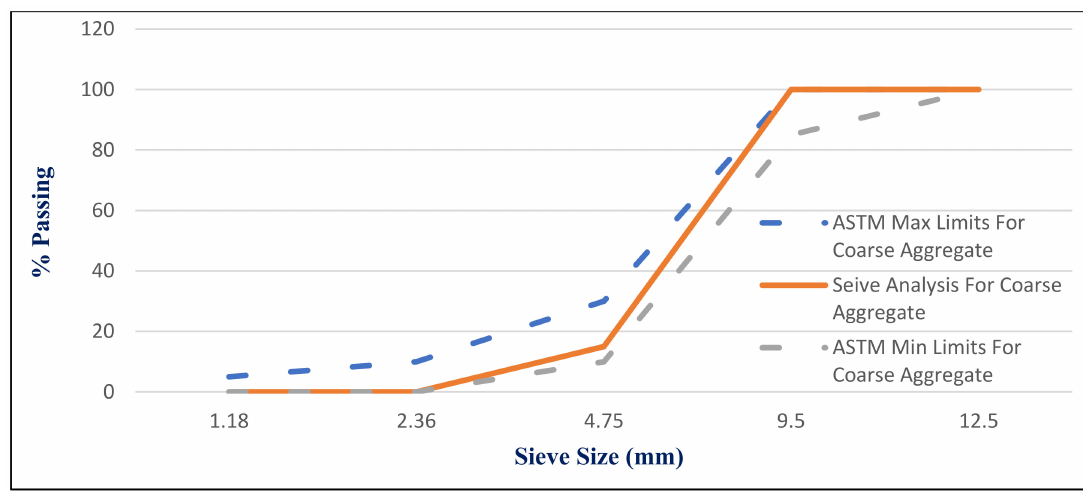
Figure 7. Dolomite grading